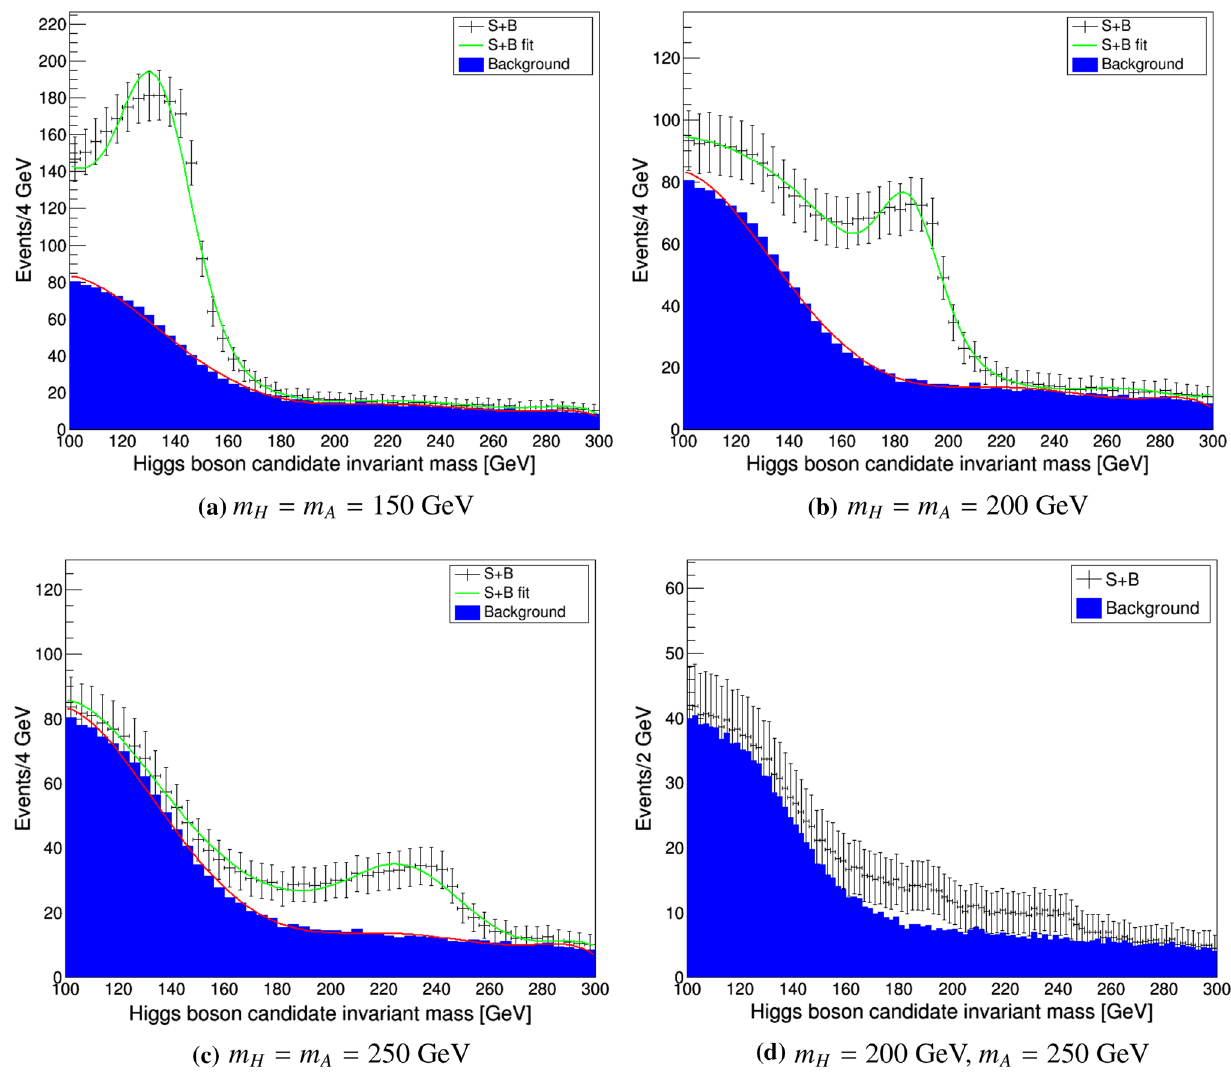
Fig. 4 The b -jet pair invariant mass in signal and background